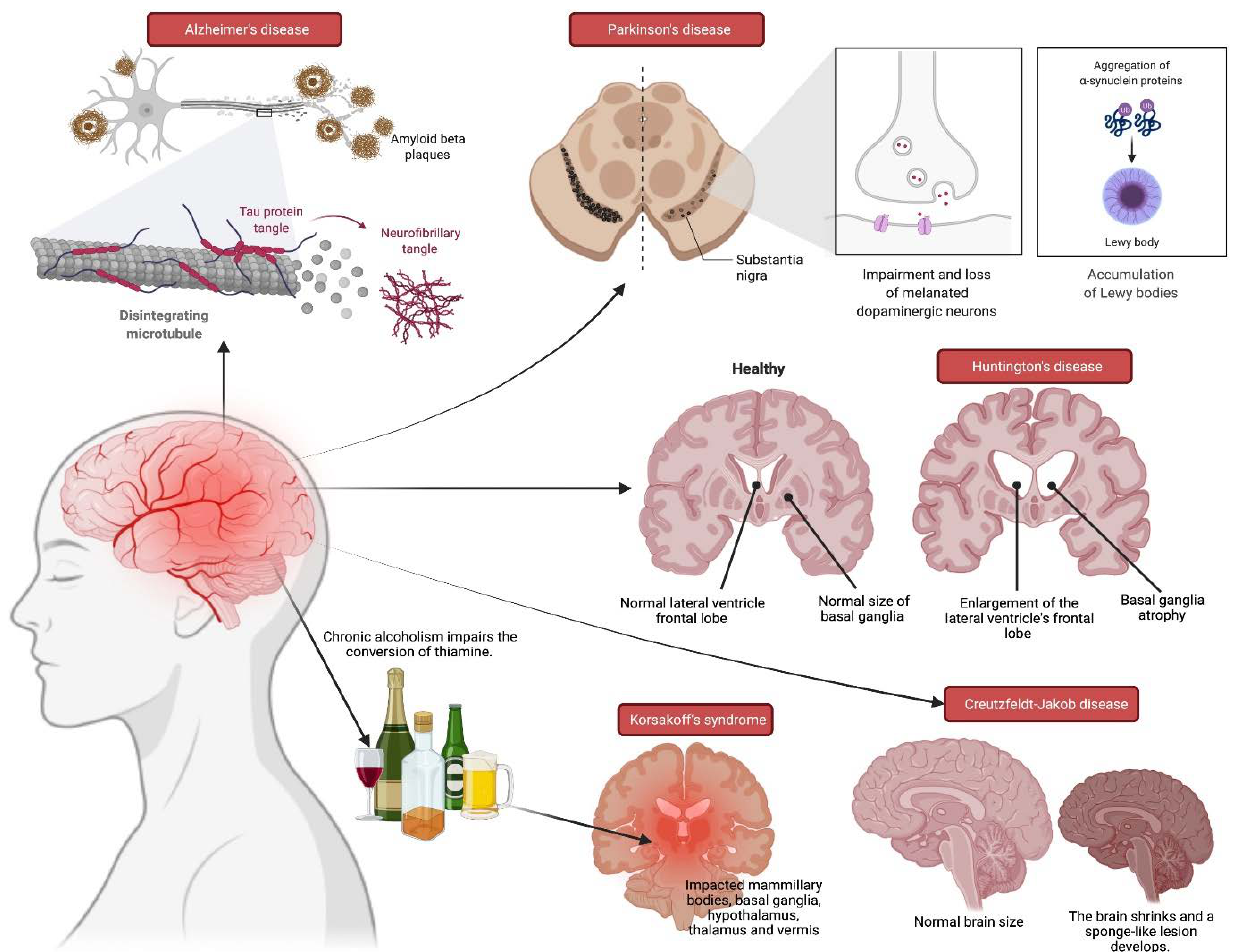
Figure 1. Disorders of the brain that can lead to memory impairment.